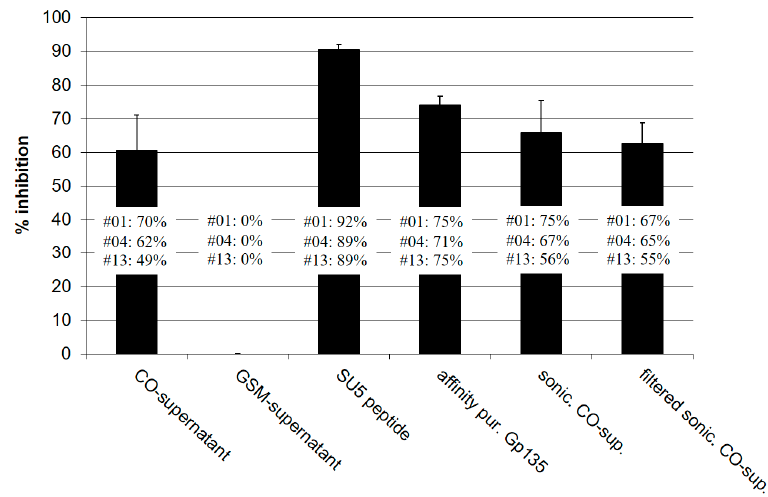
Figure 3. SU5 epitopes are available for binding in the supernatants of virus infected cells: Crude, sonicated and filtered supernatants of CAEV-CO infected GSM cells were tested in a SU5-total ELISA competition assay. Virus titers were 10 6.75 and 10 3.25 TCID50 for crude and sonicated